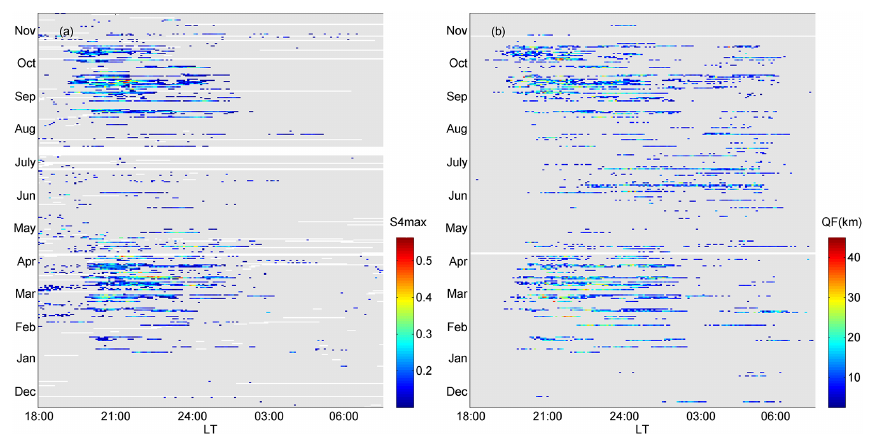
Figure 2. Seasonal and local time (LT) variations of (a) S4max and (b) QF indices observed over Sanya during December 2011–November 2012.